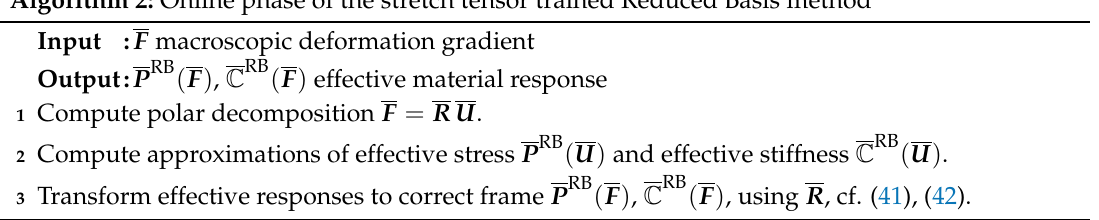
Algorithm 2: Online phase of the stretch tensor trained Reduced Basis